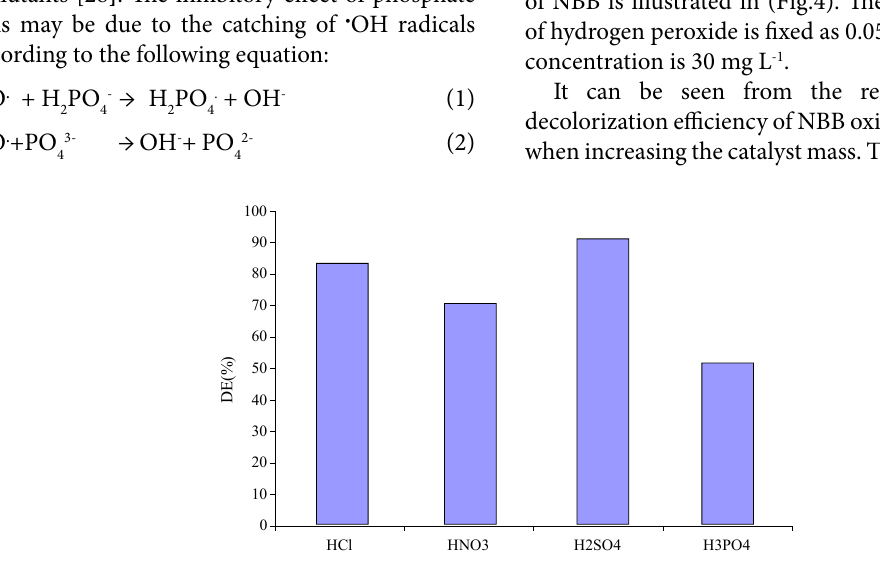
=30mg/L, [H O ]=0.005m M, catalyst mass=0.05g) i 2 2